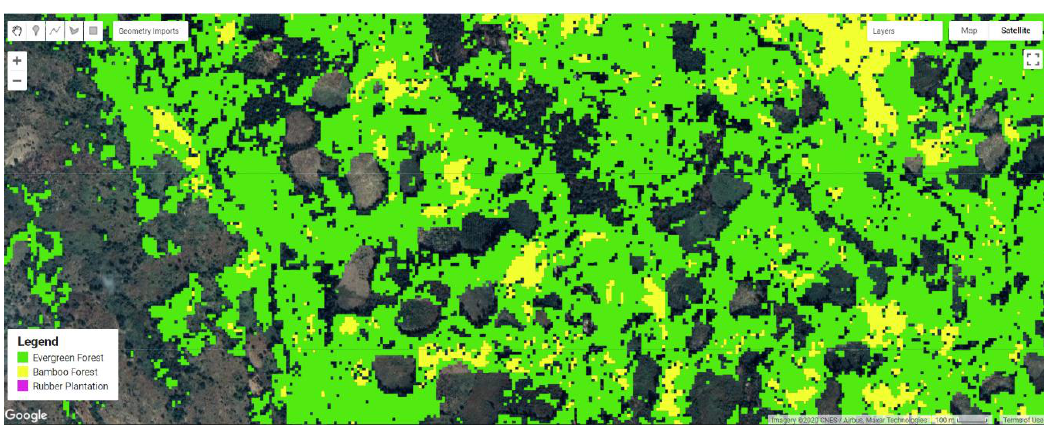
Figure 14. Example of Landsat 8 PBTC 2018 map with 89% overall accuracy. Green indicates evergreen forest, and yellow represents the distribution of bamboo. The background image is very high resolution (VHR) imagery in GEE.